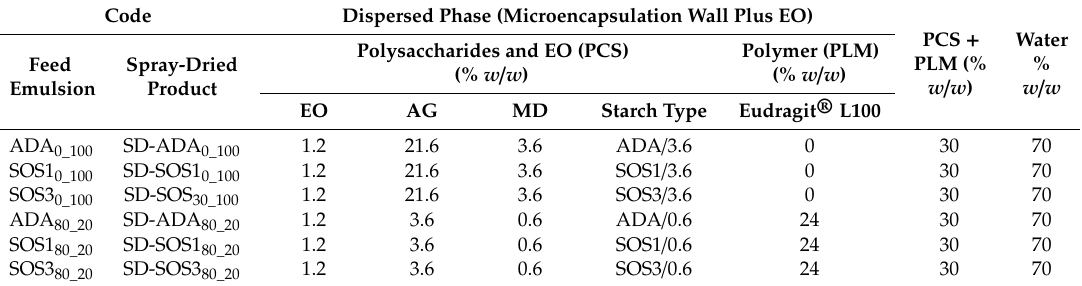
Table 1. Coding of feed emulsions and corresponding spray-dried essential oil (EO) products and composition of the dispersed phase of the feed emulsions. Code Dispersed Phase (Microencapsulation Wall Plus